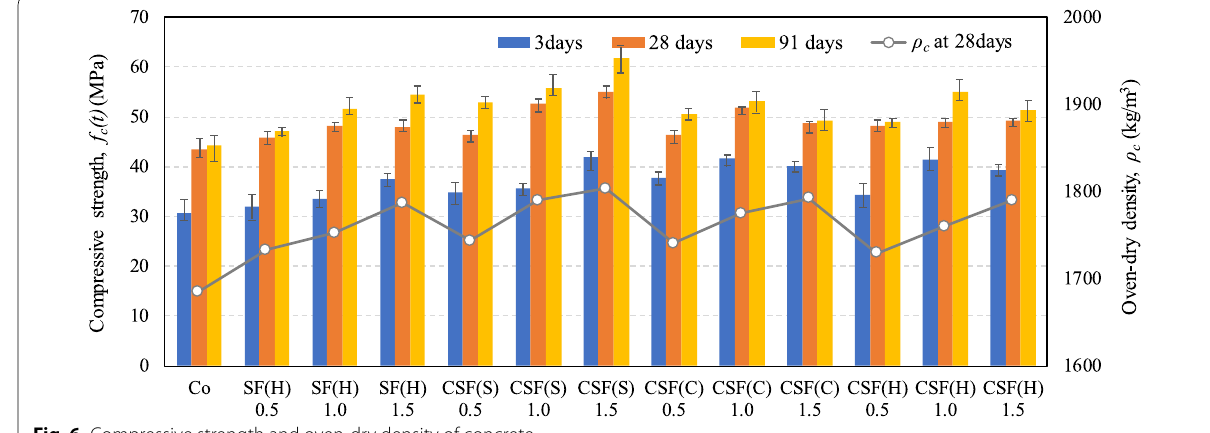
Fig. 6 Compressive strength and oven‑dry density of concrete.